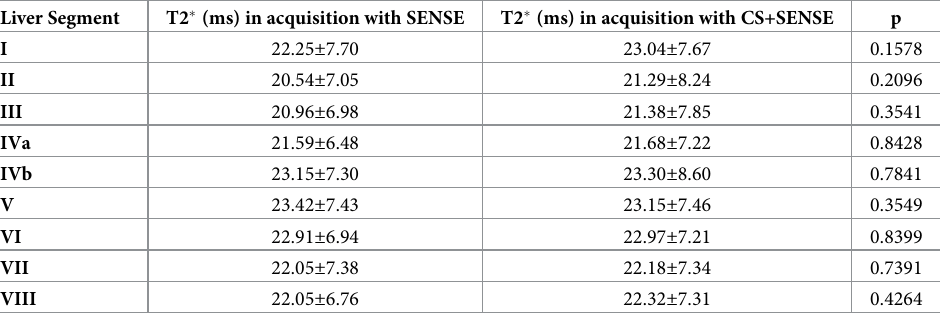
Table 3. Liver Segment T2 � (ms) in acquisition with SENSE